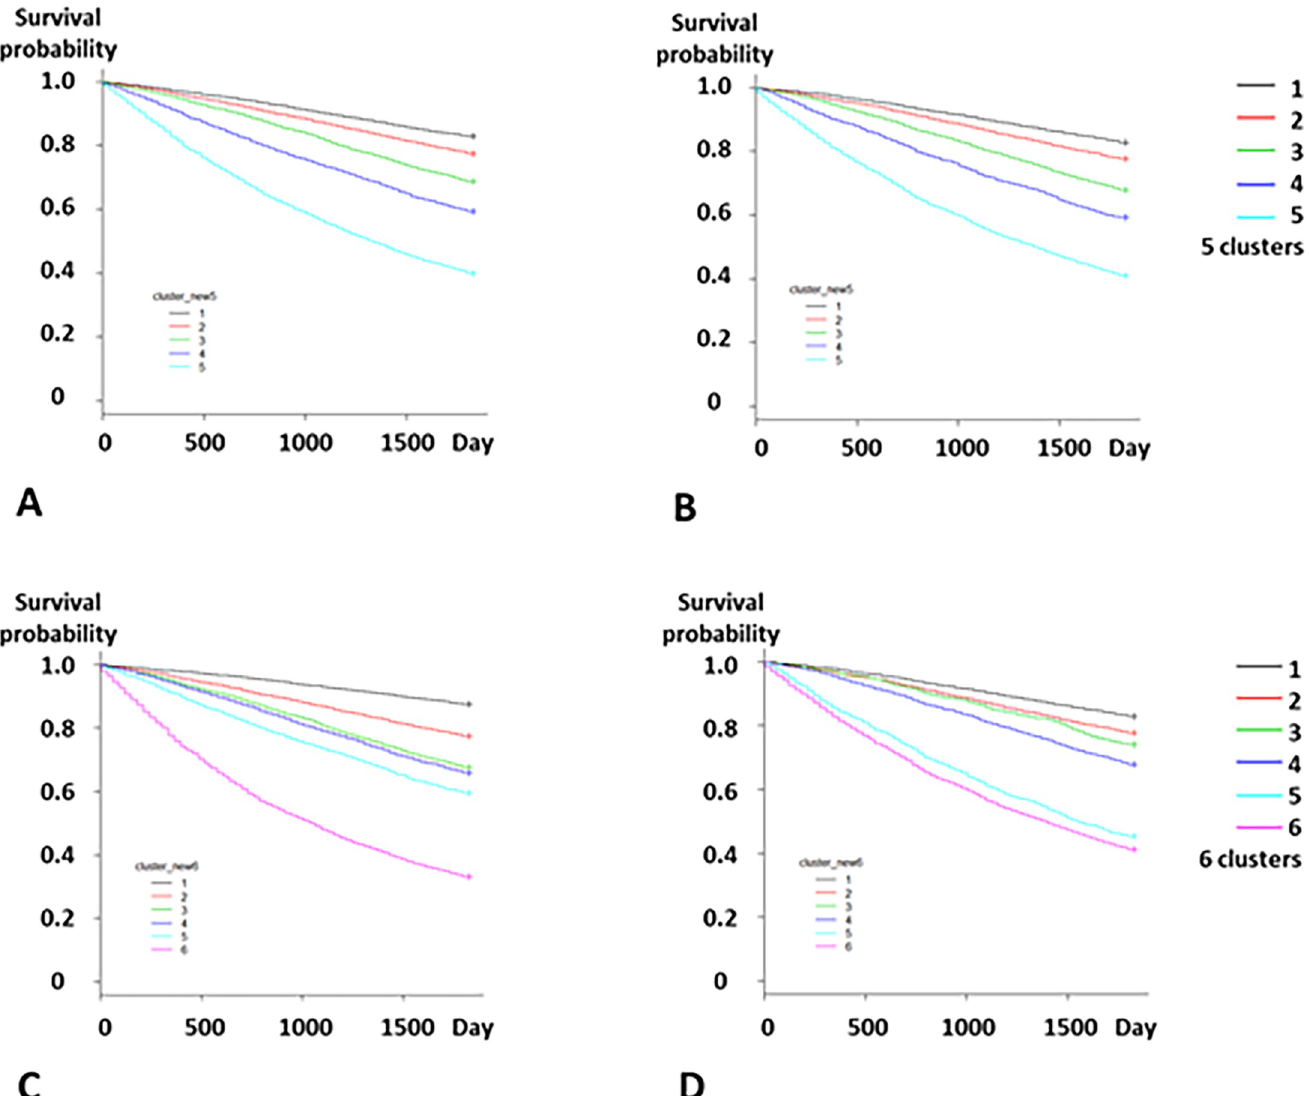
Fig 8. Association between number of clusters and 5-year mortality. A. Five clusters in the development dataset. B. Five clusters in the validation dataset. C. Six clusters in the development dataset. D. Six clusters in the validation dataset. Kaplan-Meier survival curves show that the low-risk group had the highest survival probability for the both